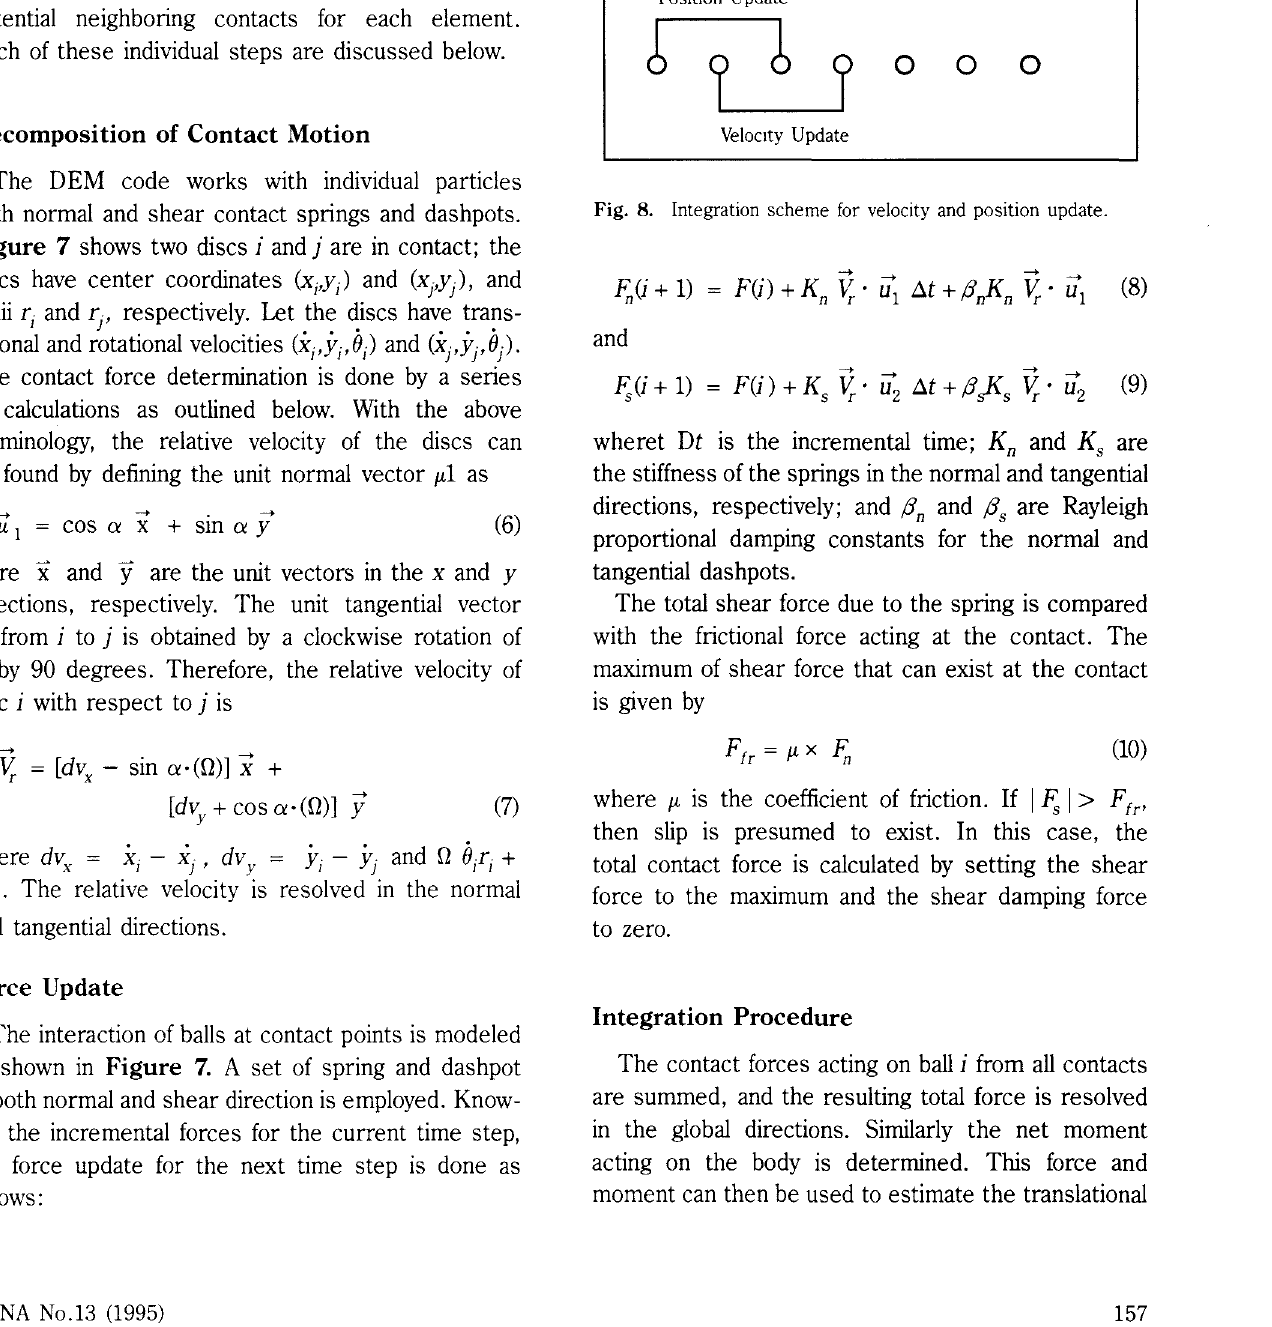
Fig. 7. Representation of a contact by a pair of spring and dash pot.